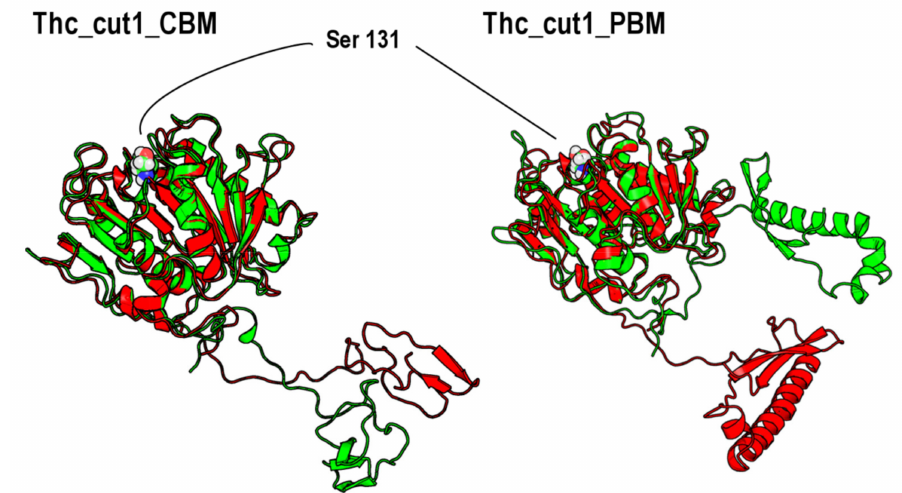
Figure 4. Initial (in red) and final (in green) structures of Thc_Cut1_CBM and Thc_Cut1_PBM after 25 ns of MD simulation. Protein structures are represented in cartoon mode; the catalytic serine is represented in sphere mode and